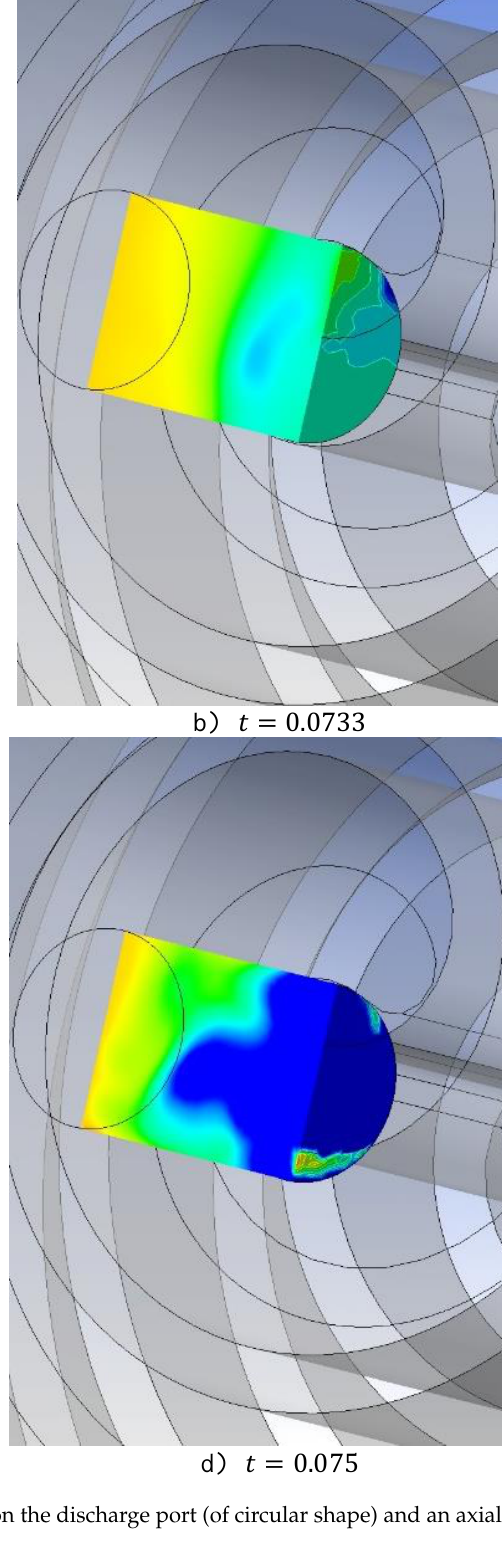
Figure 13. Contour plots of the pressure at the scroll discharge located on the discharge port (of circular shape) and an axial section plan (rectangular shape).